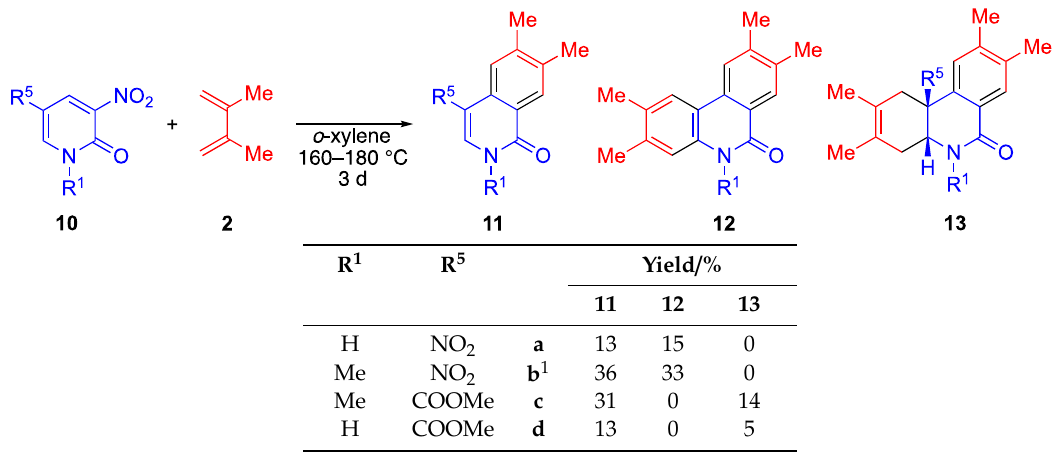
Table 4. Cycloaddition of 5-substituted 3-nitropyridones 10 with diene 2 .